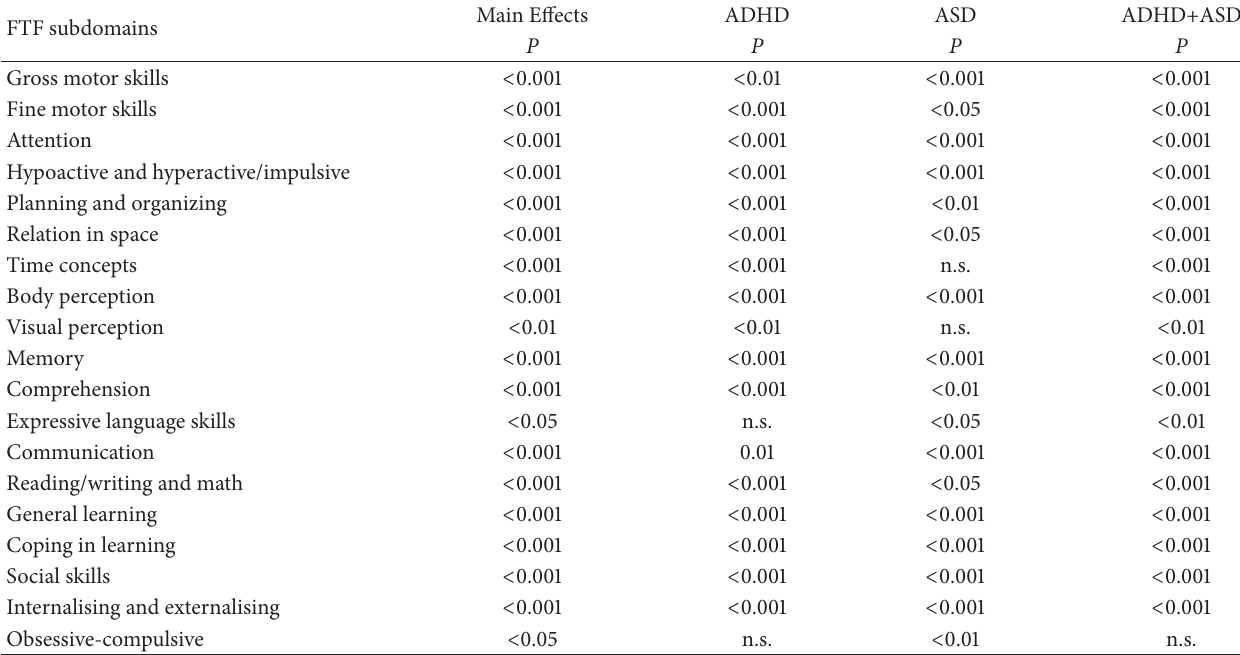
Table 3: Comparisons in childhood problems between ADHD/ASD groups and other psychiatric disorders